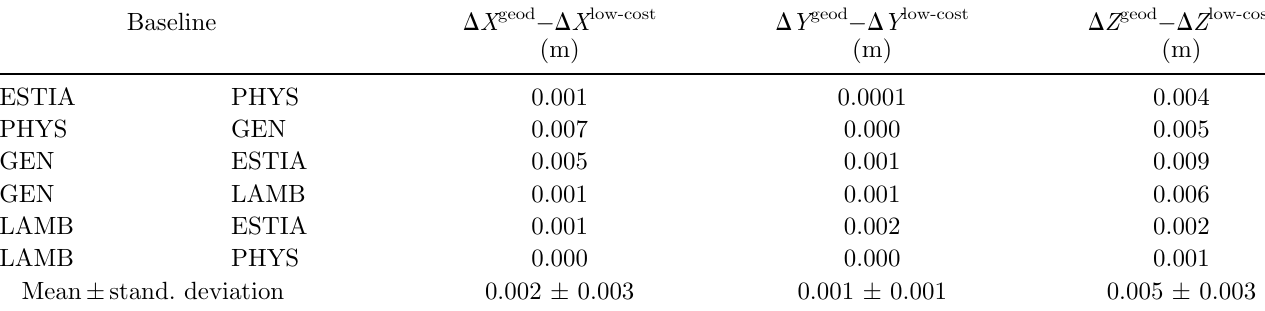
Table 7. Differences in baseline components (low-cost vs. geodetic receivers).